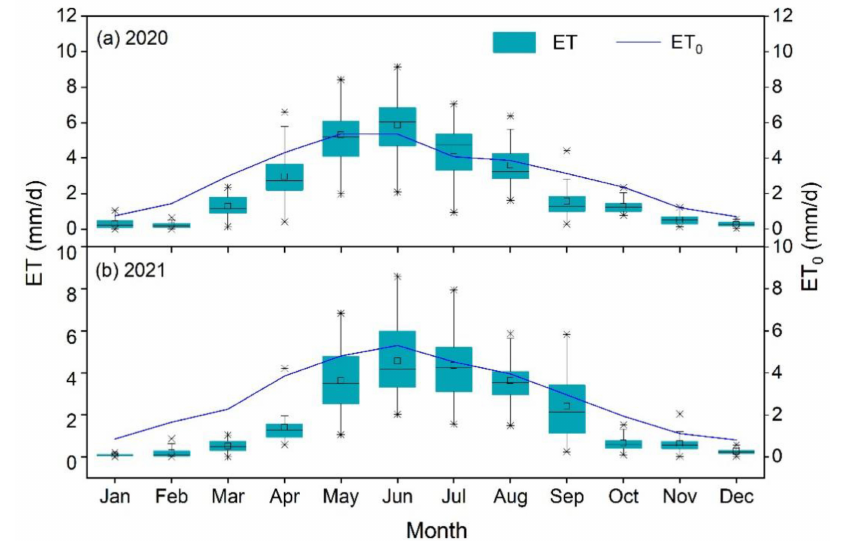
Figure 5. Evapotranspiration (ET) changes at the turf experiment site during 2020 ( a ) and 2021 ( b ). The top and bottom range of the box represent the 25th and 75th percentiles. The box whisker represents an outlier ranger and stars are extrema. The line and square within the box represent medium and mean values,